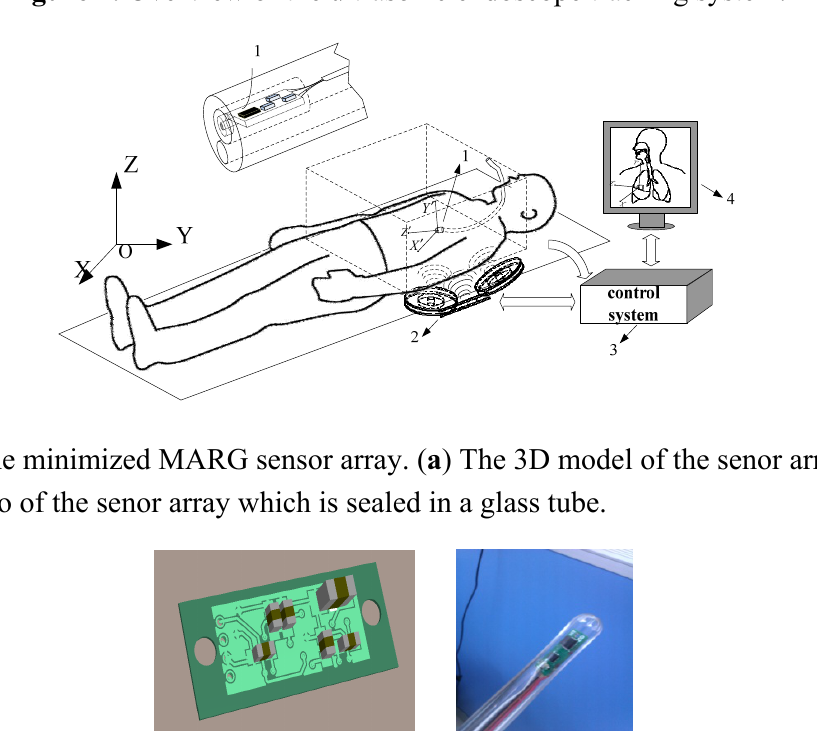
Figure 1. Overview of the ultrasonic endoscope tracking system.